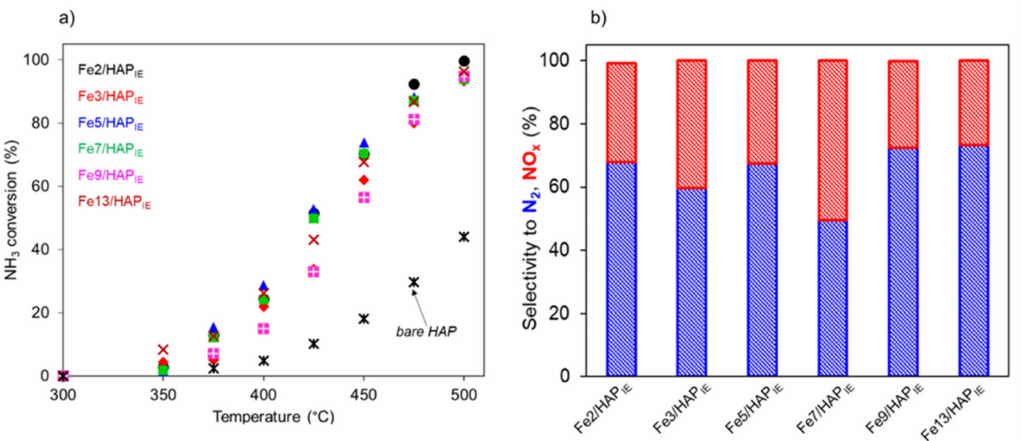
Figure 3. NH 3 -SCO catalytic activity results on Fe / HAP samples: ( a ) profiles of NH 3 conversion as a function of temperature. ( b ) Selectivity to N 2 (blue bars) and to NO x (red bars) at 50% of NH 3 conversion. Reaction conditions: [NH 3 ] = 500 ppm, [O 2 ] = 10,000 ppm; GHSV = 30,000 h − 1